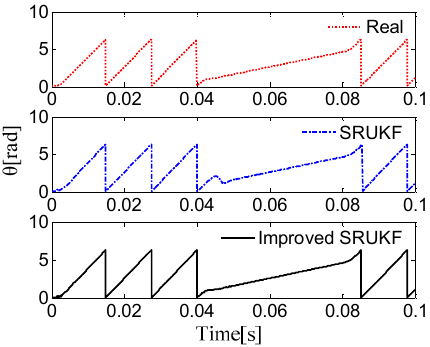
Figure 8. Speed estimation at speed step response.